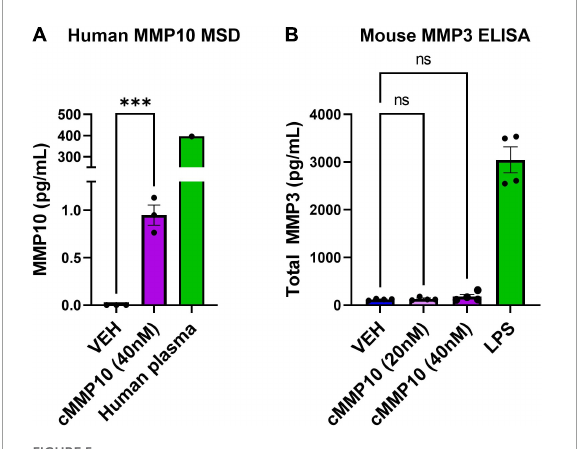
FIGURE5 Microglia release more MMP10 in response to cMMP10 treatment. ELISAs and MSD were conducted with supernatants collected after exposure to cMMP10 or VEH. (A) Microglia treated with cMMP10 (40 nM) for 24 h increased the release of MMP10 as measured by the MMP10 MSD R-plex ( n = 3–4 wells/treatment). One human plasma served as a positive control. (B) Microglial MMP3 release did not occur in response to MMP10 at any dose ( n = 4 wells/treatment; no significance). LPS served as a positive control. Values reported are representative of one experiment that had a minimum of three biological replicates, or wells, per treatment. This experiment was performed independently at least two additional times. Values are reported as mean ± SEM; Unpaired Student’s t -test (MSD) or one-way ANOVA compared to VEH (ELISA) Dunnett’s post-hoc test; ∗∗∗ P ≤